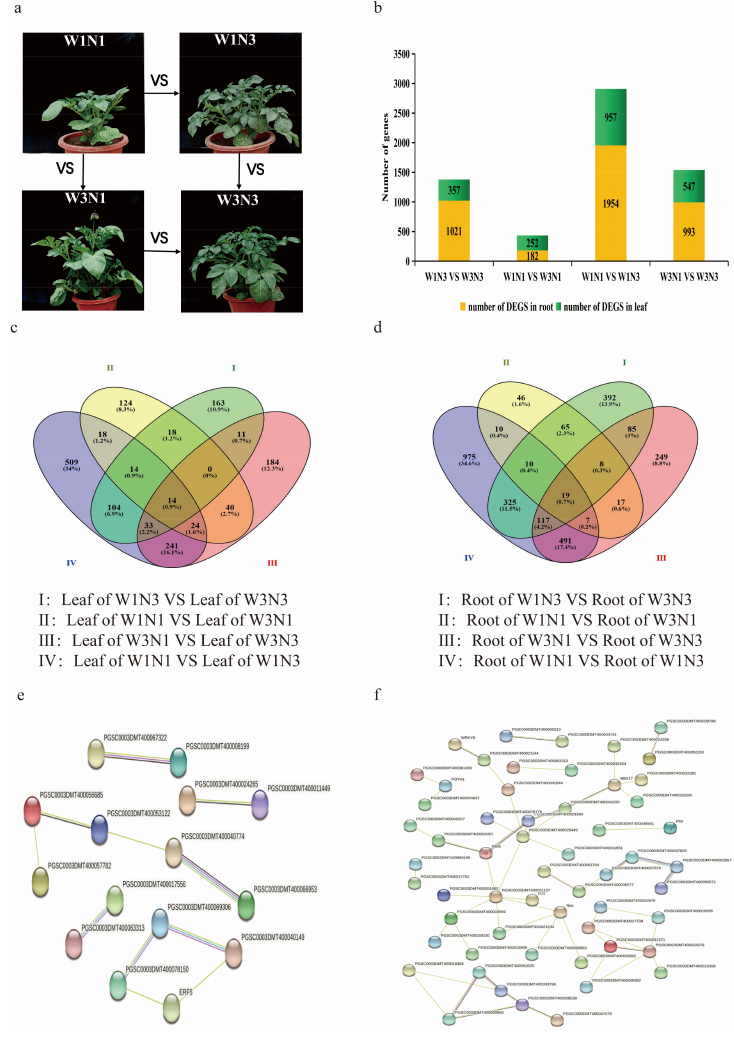
Figure 1. Differentially expressed gene (DEG) identification. ( a ) Diagram showing the samples compared in this analysis. ( b ) Distribution of DEGs (FDR < 0.05 and |log2(fold change)| ≥ 1) between treatment groups in two tissues. (c-d) Unique and shared DEGs between treatment groups in leaf tissue ( c ) and root tissue ( d ). ( e , f ) Unique and shared differentially expressed transcription factors (TFs) in leaf tissue ( e ) and root tissue ( f ). In the network, the circular node with a specific number represents the protein, and the interconnecting lines represent the source by which protein interactions are derived. Sources of protein interaction were represented with black, pink, green, and blue lines that represent co-expression, experimental data, text mining, and homology,